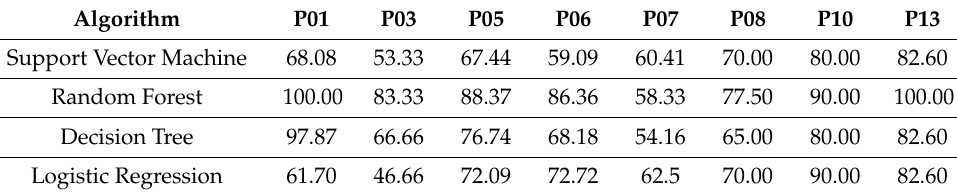
Table 9. Accuracy (%) of the classification of mood states based on 3 selected smartwatch